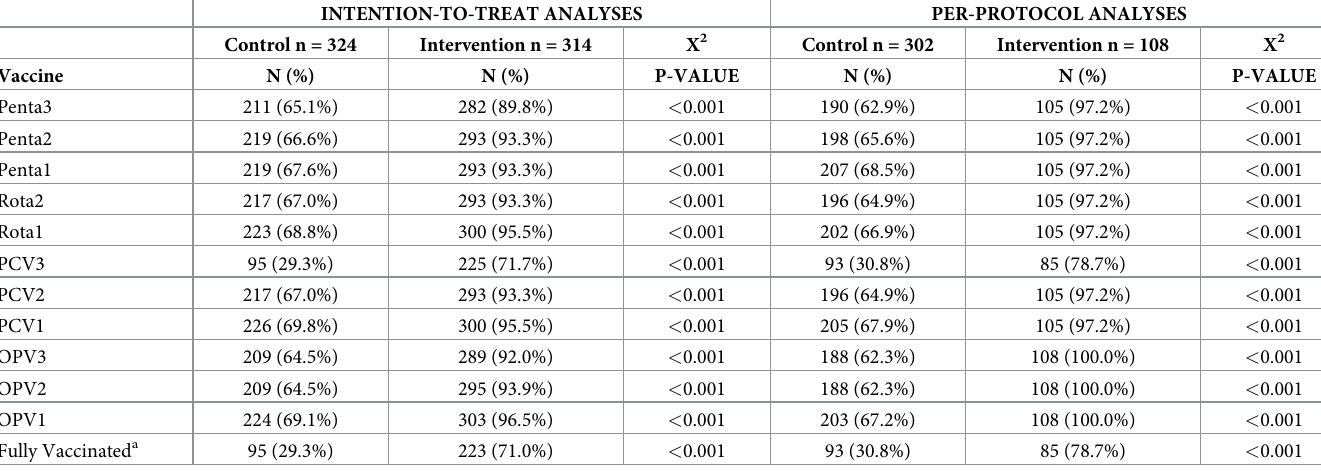
Table 2. Vaccination outcomes in the control and intervention